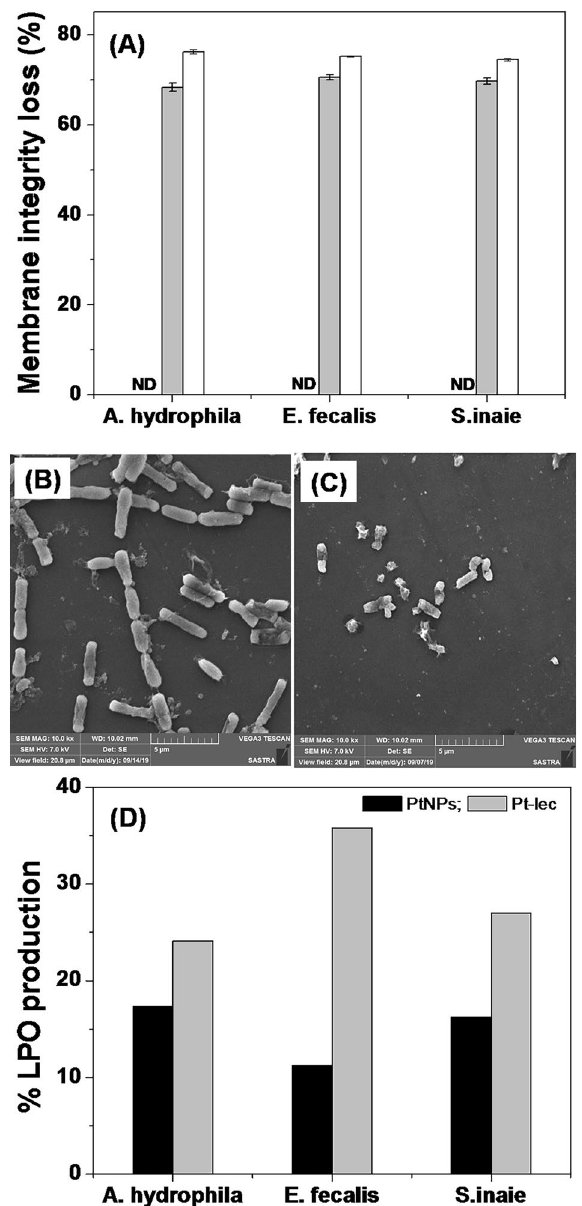
Figure 3. Antibacterial mechanism. ( A ) Membrane integrity assay. Bacteria were treated with 1× MIC Pt-lec (black bar) and 25 µM Triton X 100, positive control (white bar). ND not detectable fluorescence from untreated cells, negative control; ( B ) Representative SEM image of untreated E. fecalis , ( C ) E. fecalis treated with 1X MIC Pt-lec; ( C ) TBARS assay. Excess LPO was produced in the cells treated with 1X MIC